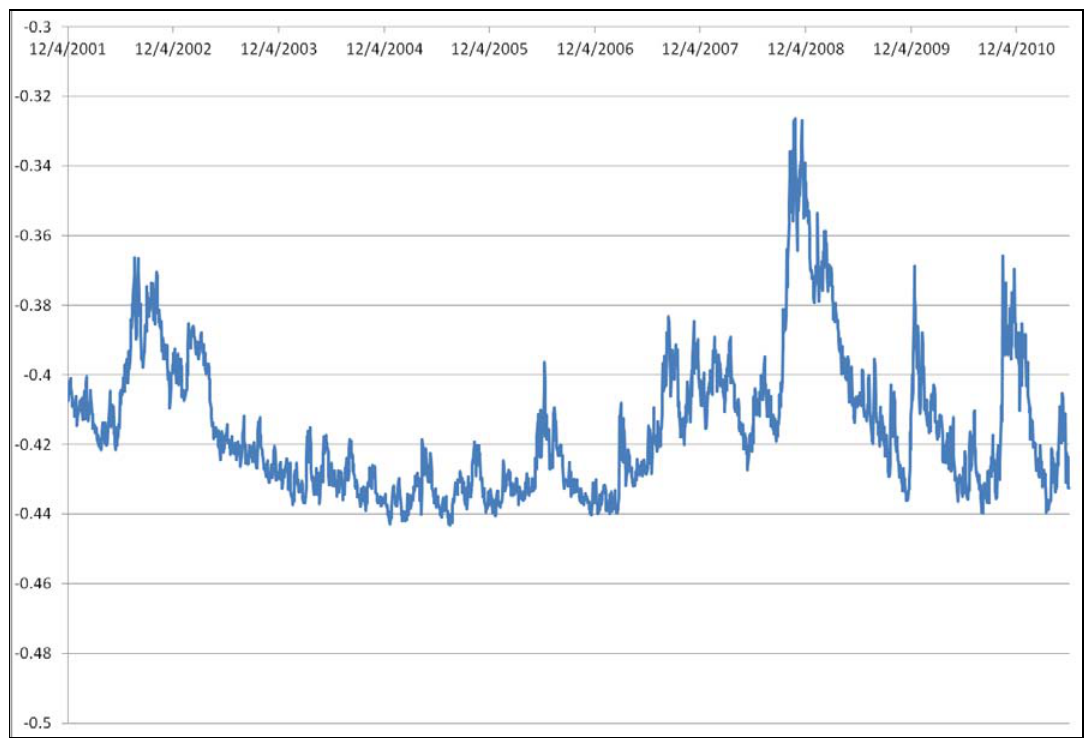
Figure 3. Index of global risk